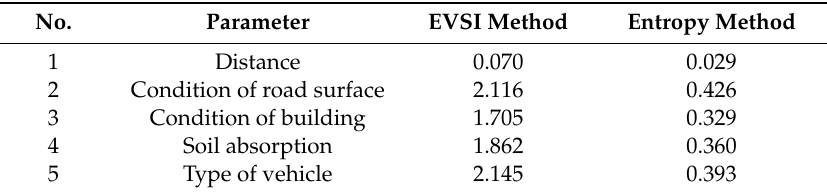
Table 3. A summary of the reliability of the